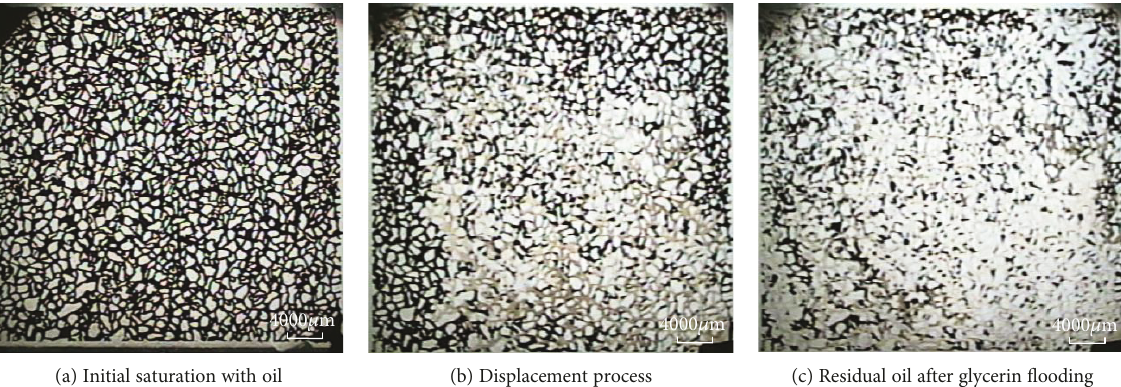
Figure 7: Oil distribution with glycerin fl ooding in a simulation model (the dark area is oil, and the lighter the color is, the lower the saturation is; the light area represents the displacing fl uid). Table 1: Displacement results of glycerin and viscoelastic polymer with the same viscosity (40 mPa ·